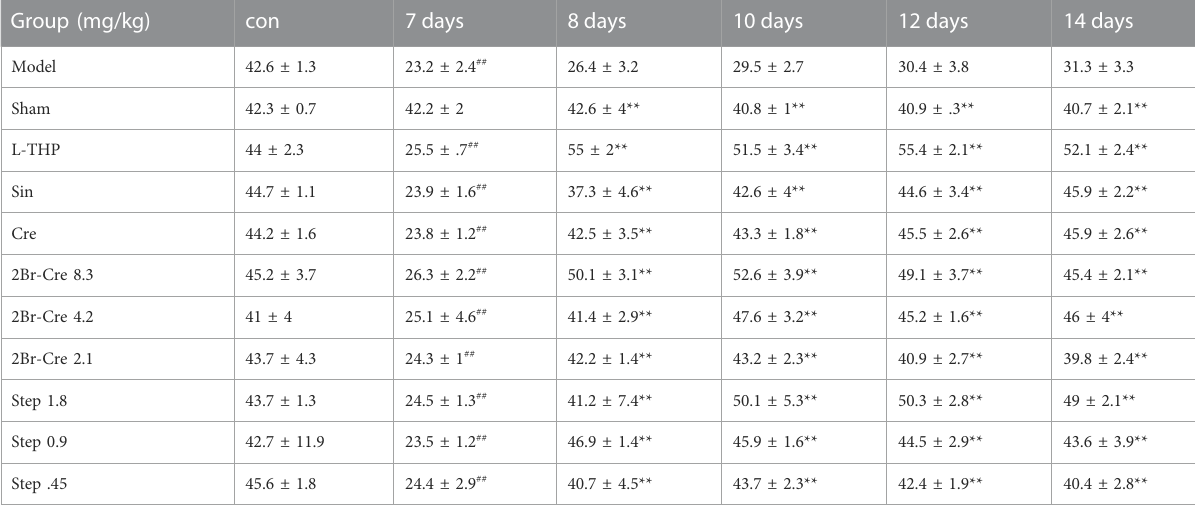
TABLE 1 PWMT of CCI rats at different times ( ‾ x ± s, n = 10). Group